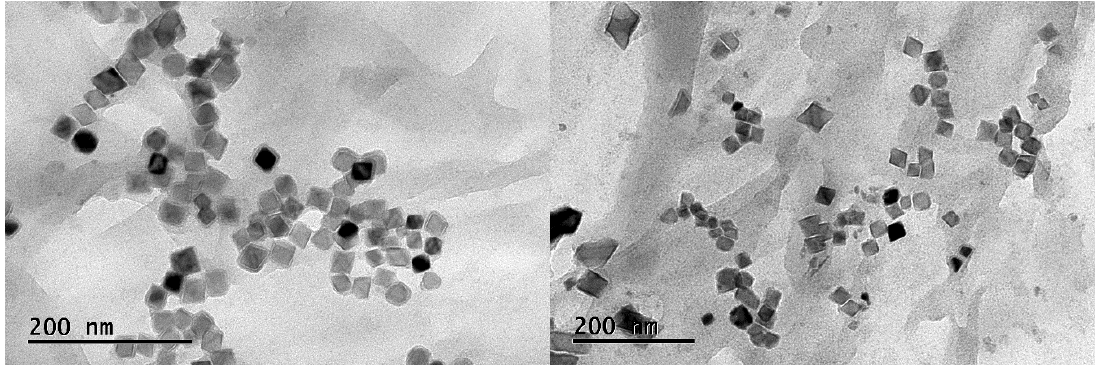
Figure 13. Typical morphology of Nb-containing precipitates.